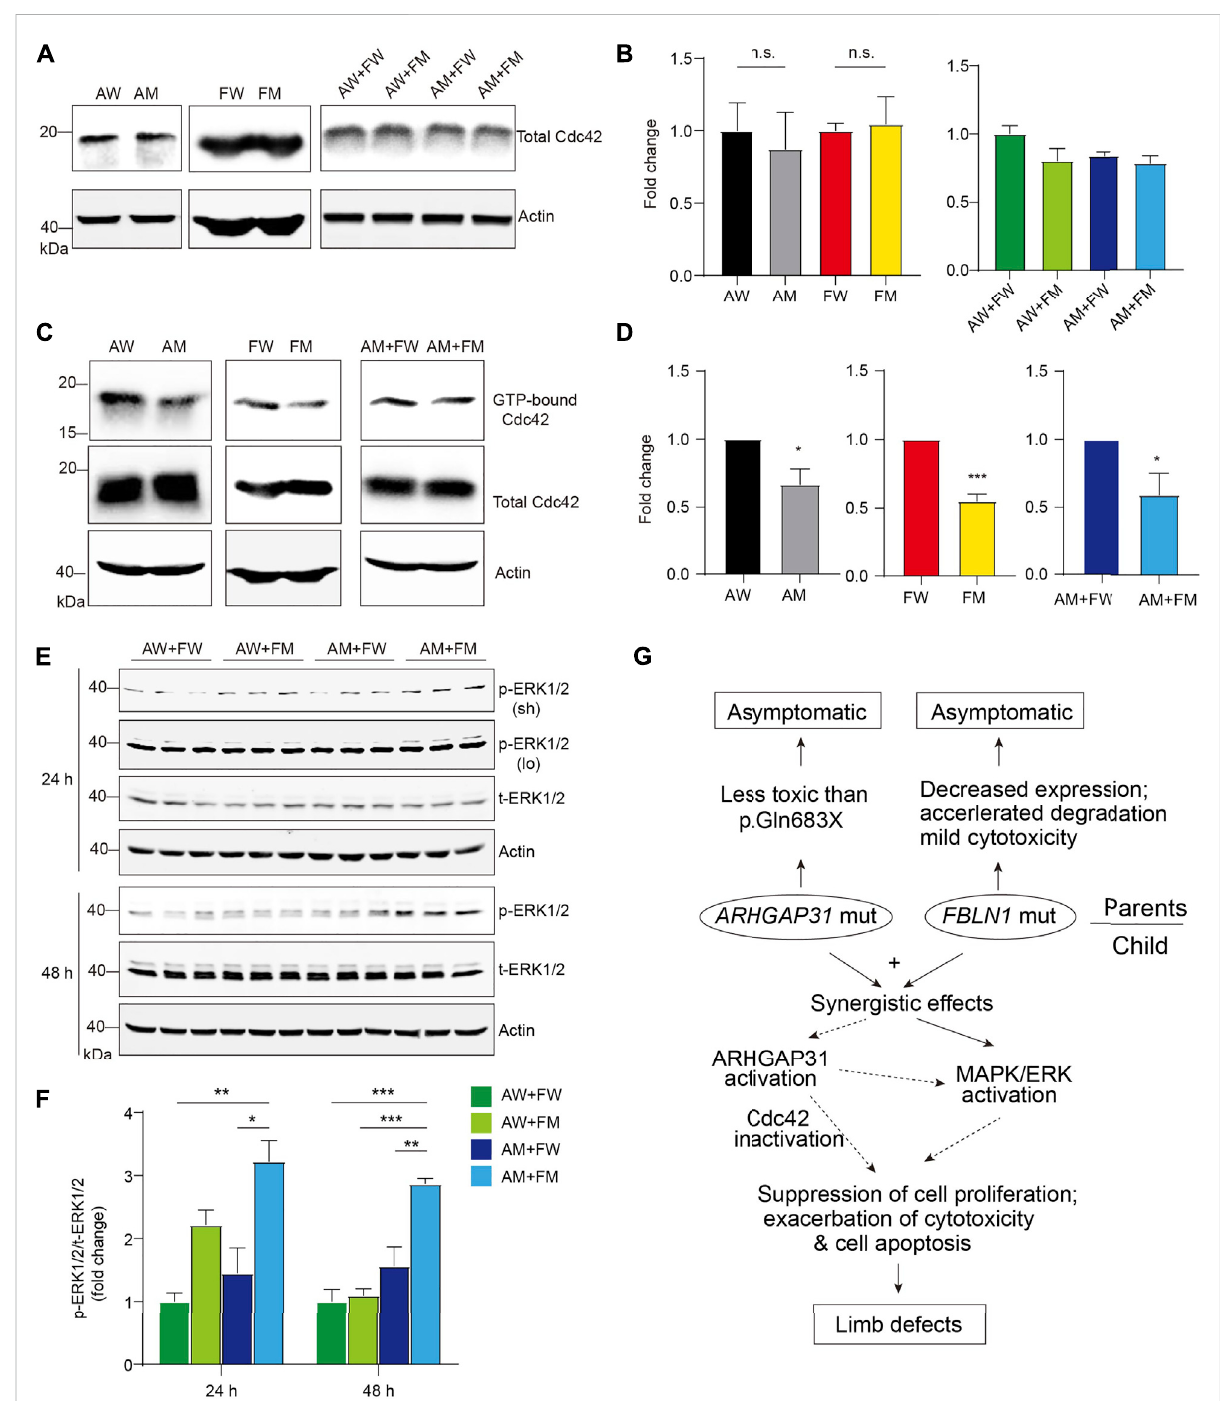
FIGURE 7 Enhanced activation of Cdc42 by ARHGAP31 and FBLN1 mutants. (A) Immunoblotting of Cdc42 expression in HeLa cell lysates after transfection. (B) Quanti fi cation of A ( n = 3 – 6 per group). (C) Active Cdc42, that is, GTP-bound form, were detected using speci fi c pull-down assay followedbyimmunoblottingoftotalCdc42inHeLacelllysatespostindicatedtransfections.Allquanti fi cationsofrespectivedensitometryareshown in (D) ( n = 3 – 4 per group). (E) HeLa cells were transfected with indicated plasmids and immunoblotted with pERK1/2 and total-ERK1/2 (t-ERK1/ 2) antibodies. Sh, short exposure and lo, long exposure. (F) Quanti fi cation of E (results of short exposure were quanti fi ed). (G) Diagram of working hypothesis that the synergetic effects of variations in ARHGAP31 and FBLN1 cause penetrance of terminal transverse limb